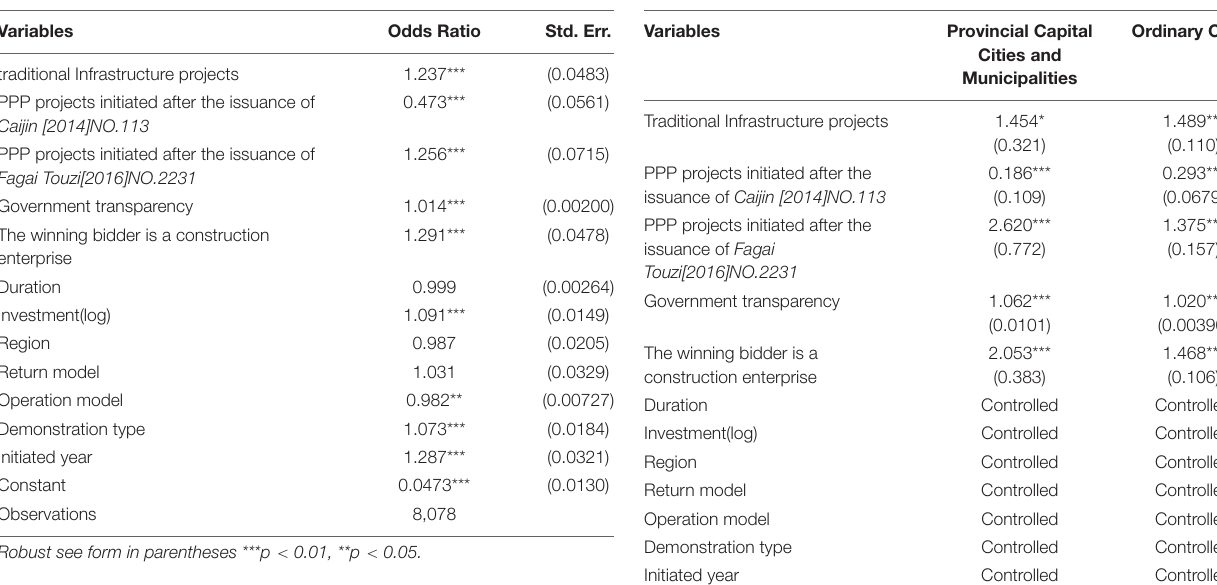
TABLE 7 | Probit regression result. TABLE 8 | Regression result of regional heterogeneity